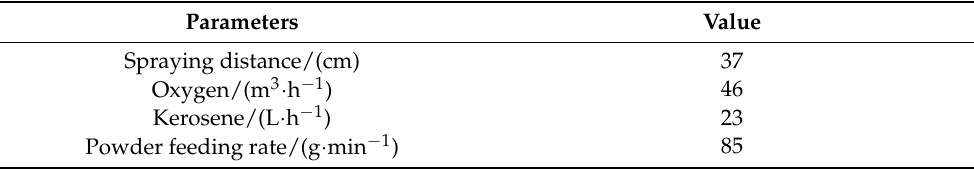
Table 1. Parameters of the supersonic flame spraying process (HVOF).